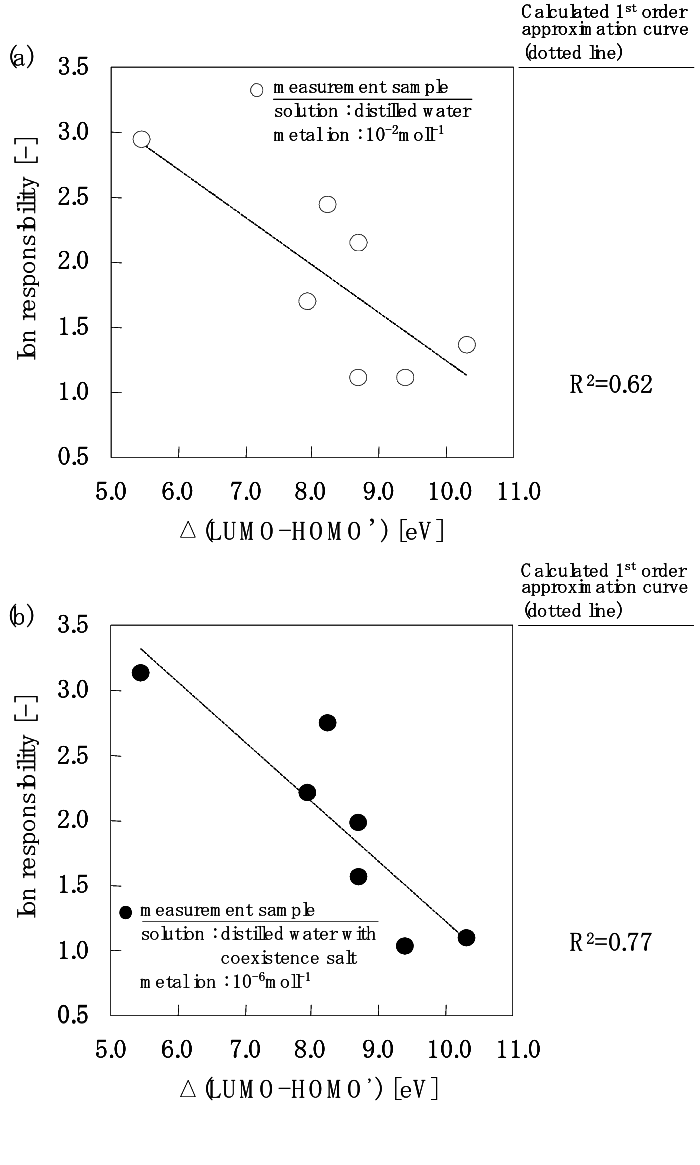
Figure 7. Relationships between the actual measured ion response value using an electrode chip and the calculated ∆ (LUMO-HOMO’) value.